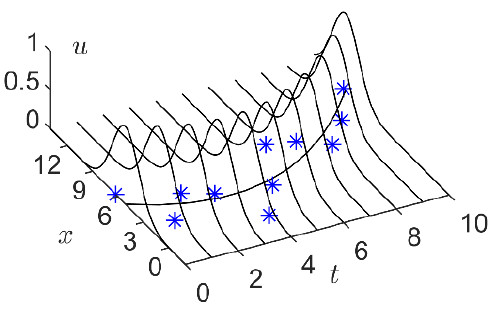
Figure 4. A Gaussian PFIG.